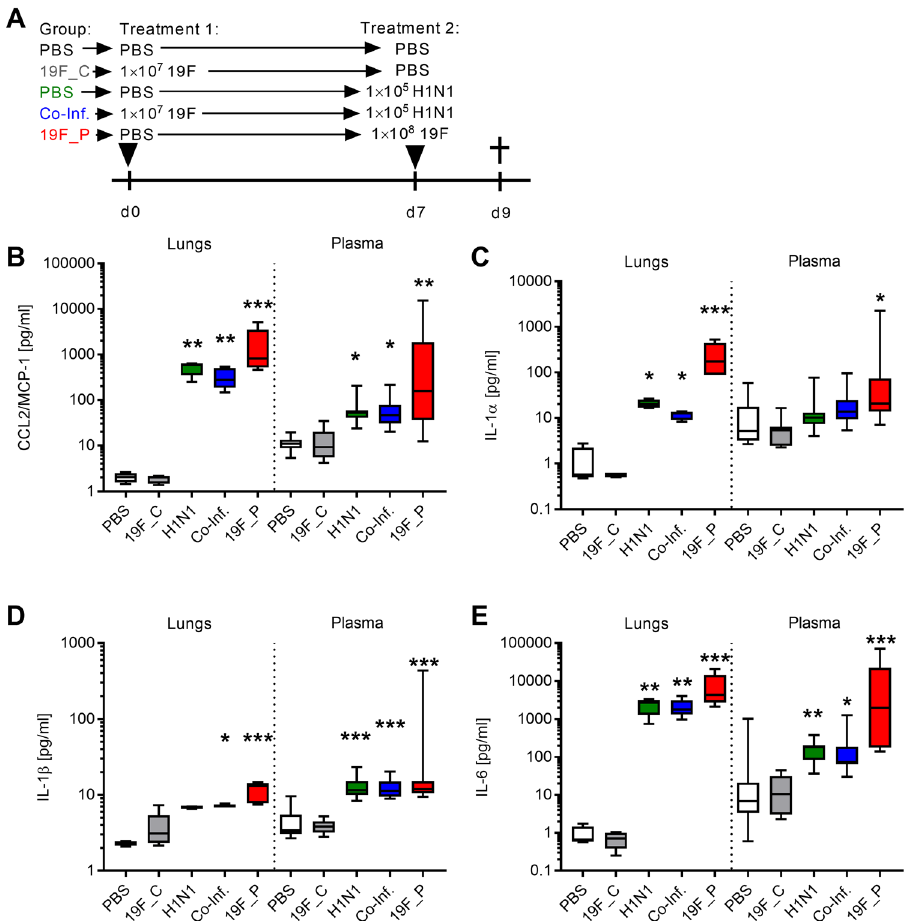
Figure 4. Local and systemic cytokine production in response to mono- and co-infections. ( A ) Scheme displaying the time line of different mice infections. Mice were sacrificed at day 9 and ( B ) CCL2/MCP-1, ( C ) IL-1α, ( D ) IL-1β, and ( E ) IL-6 levels were determined in lungs and plasma. Two independent experiments with six mice per group (total: n = 12) were performed. The data are displayed as box plots. The level of